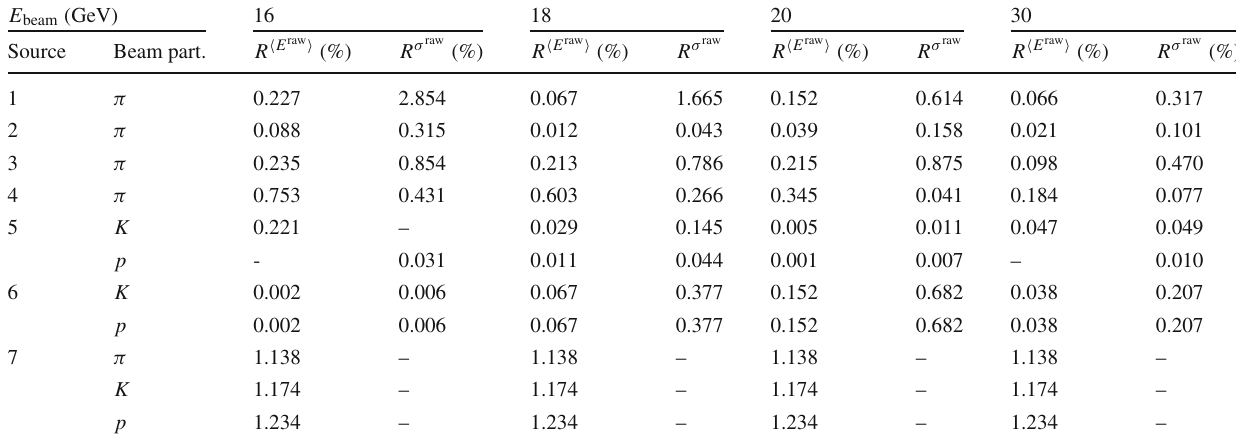
Table 7 Systematic uncertainties on the estimations of R (cid:6) E raw (cid:7) and R σ raw inpercent.Thepionmeasurementsareaffectedbytheuncertainty onthenumberofelectronscontaminatingthe e /π samples(Sources1,2 and3),onthe E raw shapeofthecontaminatingelectrons(Source4).The